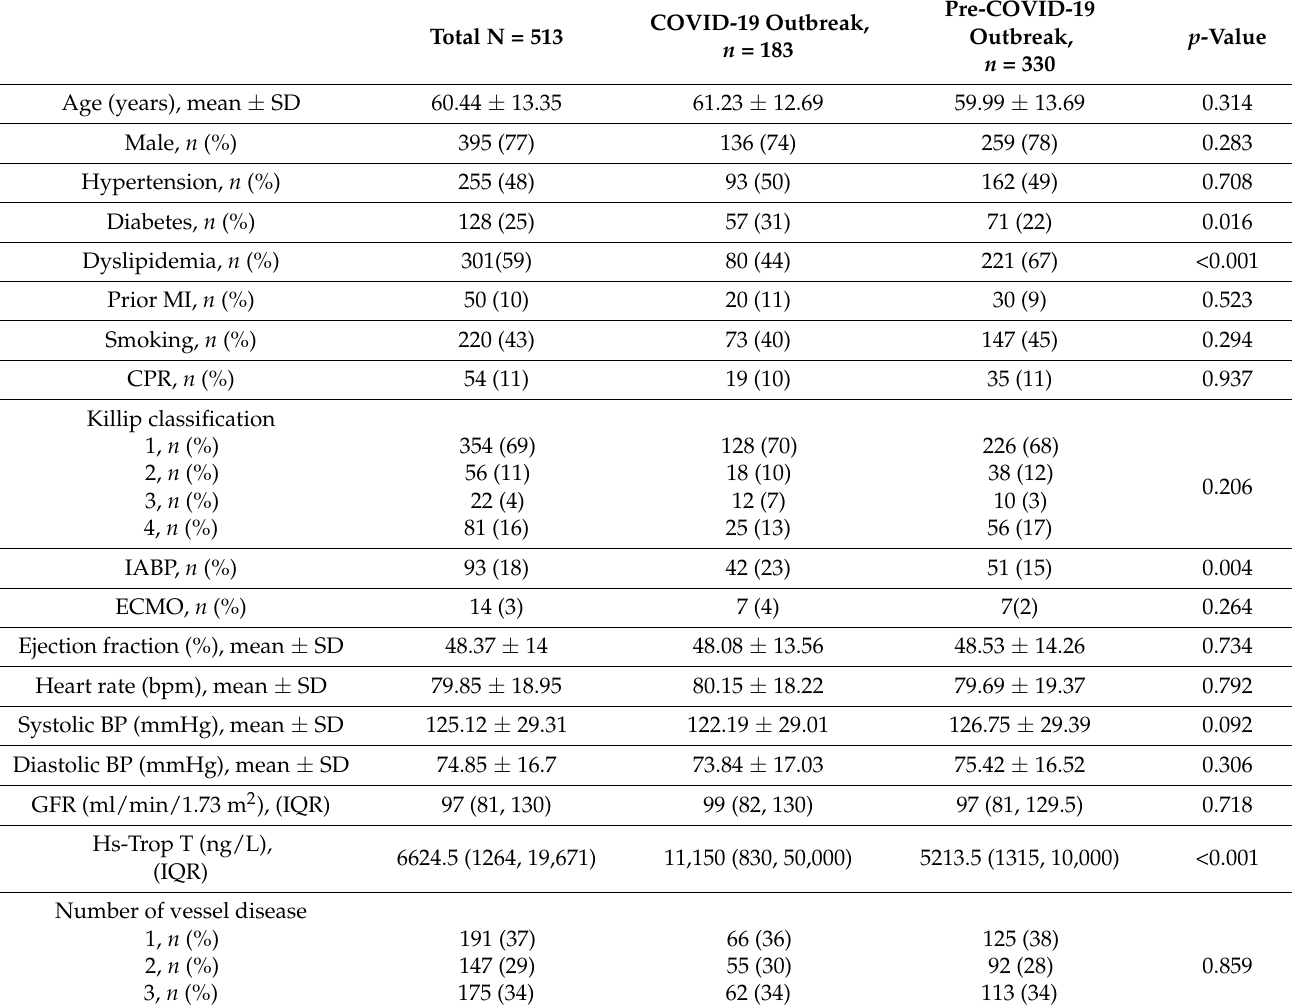
Table 1. Baseline characteristics and clinical characteristics of STEMI patients admitted in the pre- COVID-19 outbreak period and during the COVID-19 outbreak period. Pre-COVID-19 COVID-19 Outbreak, p Total N = 513 Outbreak, n = 183 n = 330